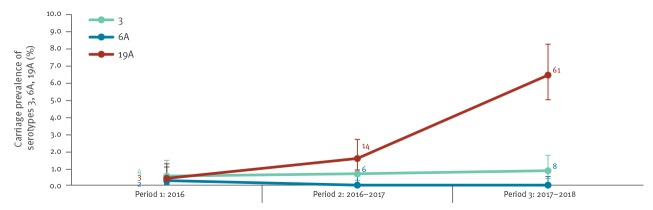
Carriage prevalence of PCV13-non-PCV10 vaccine serotypes 3, 6A, 19Aa, Belgium, 2016–2018 (n = 761 in 2016, 904 in 2016–2017, 956 in 2017–2018)